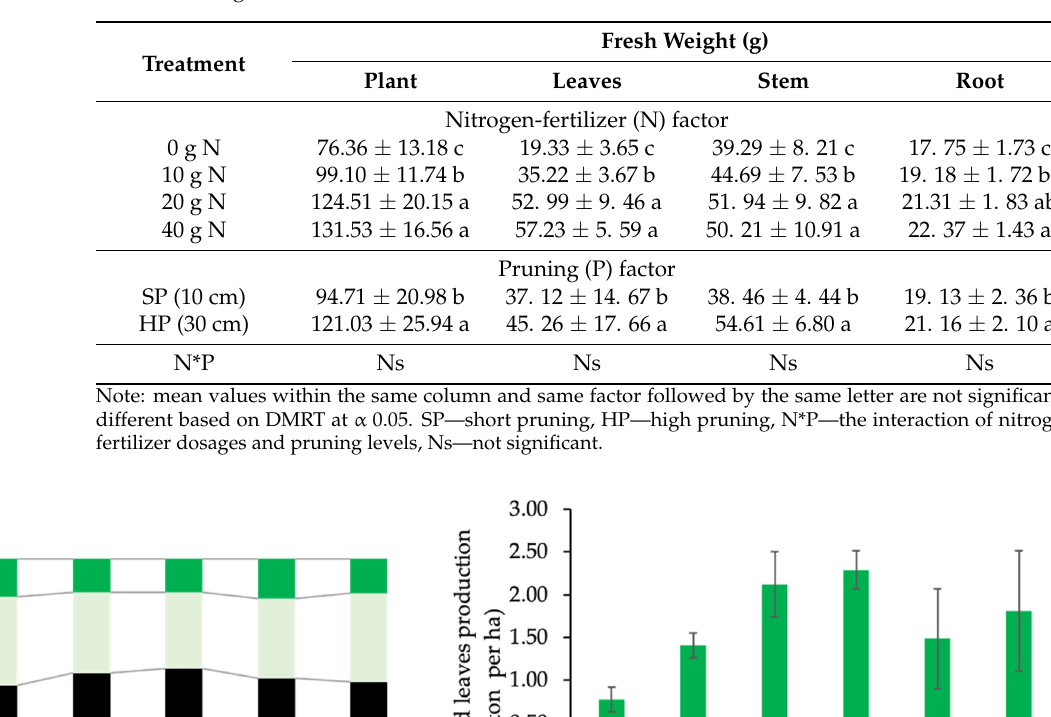
Table 3. Plant production (fresh weight) of kaffir lime under different pruning levels and nitrogen- fertilizer dosages.